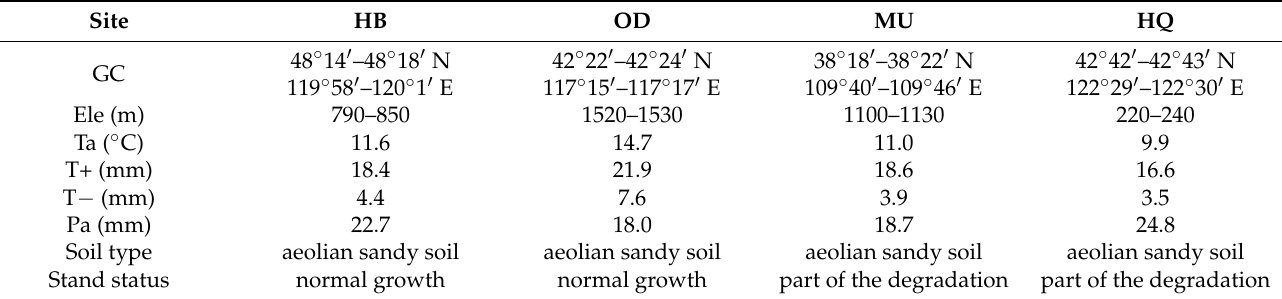
Table 1. General information of sampling